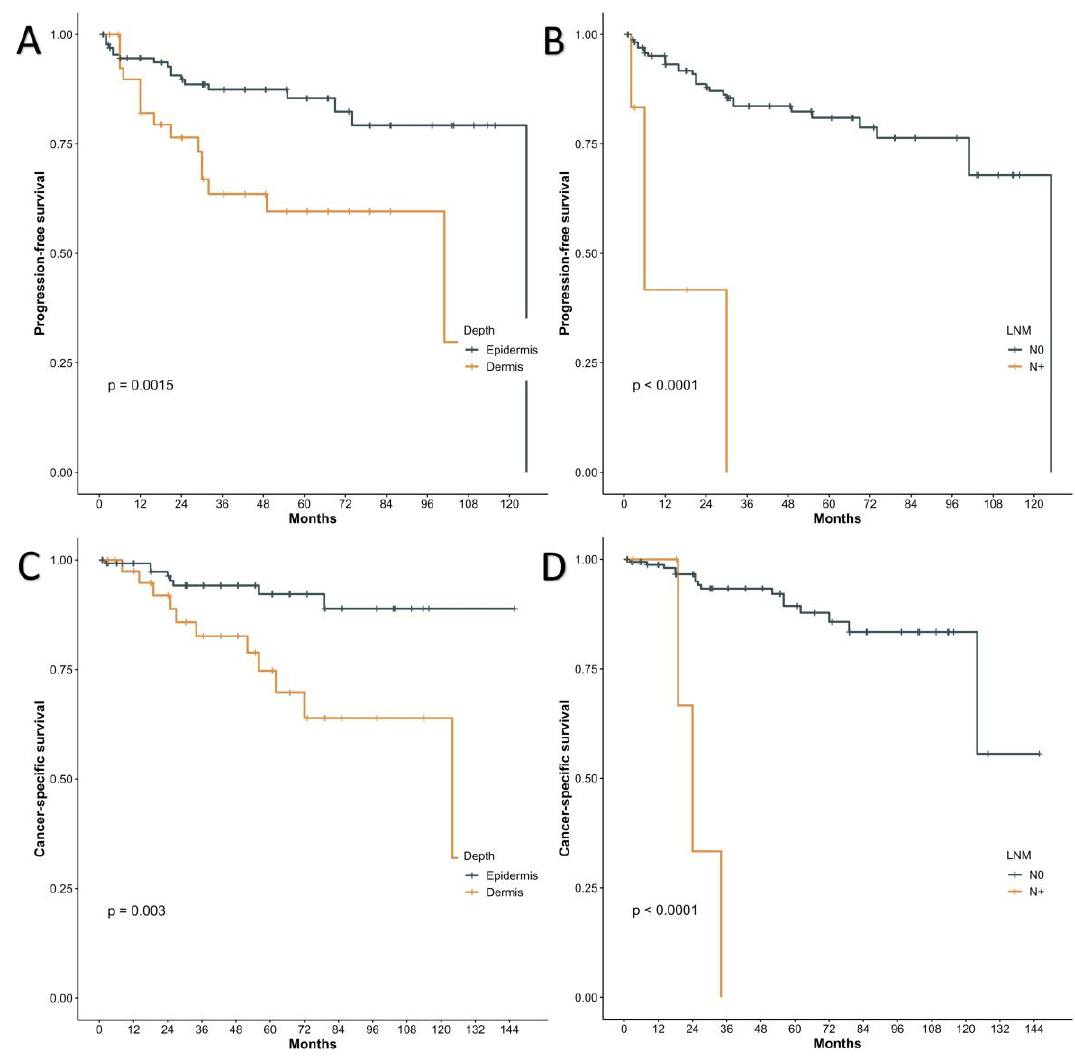
Figure 3. Kaplan – Meier curves of progression-free survival (PFS) using the data of our centre ac- Figure 3. Kaplan–Meier curves of progression-free survival (PFS) using the data of our centre cording to the tumour invasion depth (A), the status of lymph nodes (B). Kaplan – Meier curves of according to the tumour invasion depth ( A ), the status of lymph nodes ( B ). Kaplan–Meier curves of CSS using the data of our centre according to the tumour invasion depth (C), the status of lymph CSS using the data of our centre according to the tumour invasion depth ( C ), the status of lymph nodes (D) nodes ( D